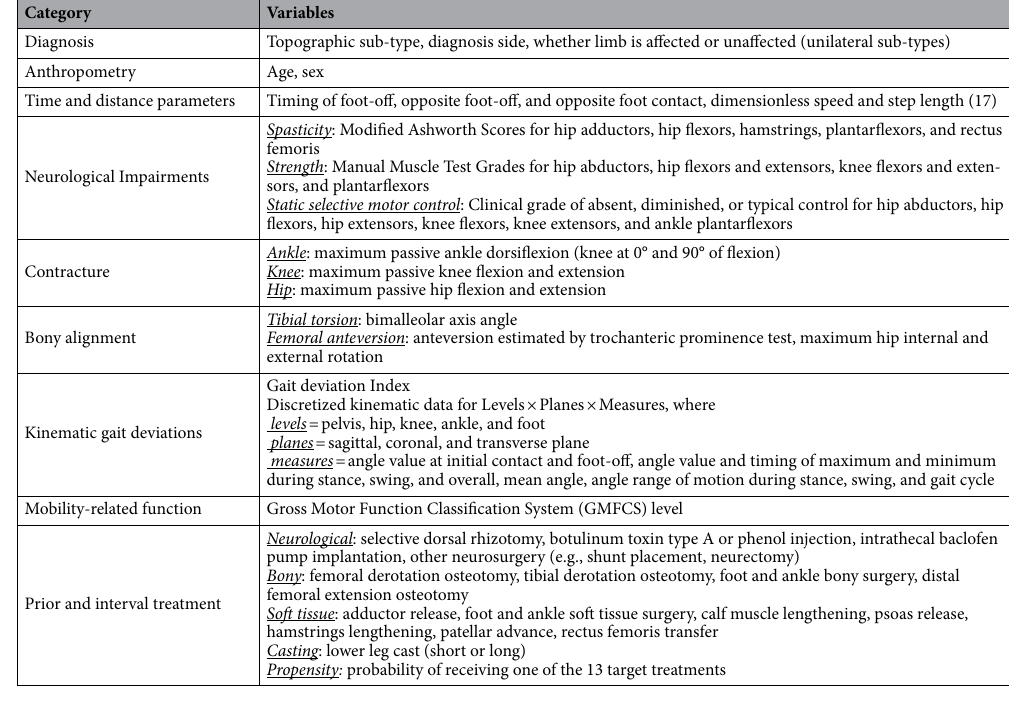
Table 6. Covariates in causal